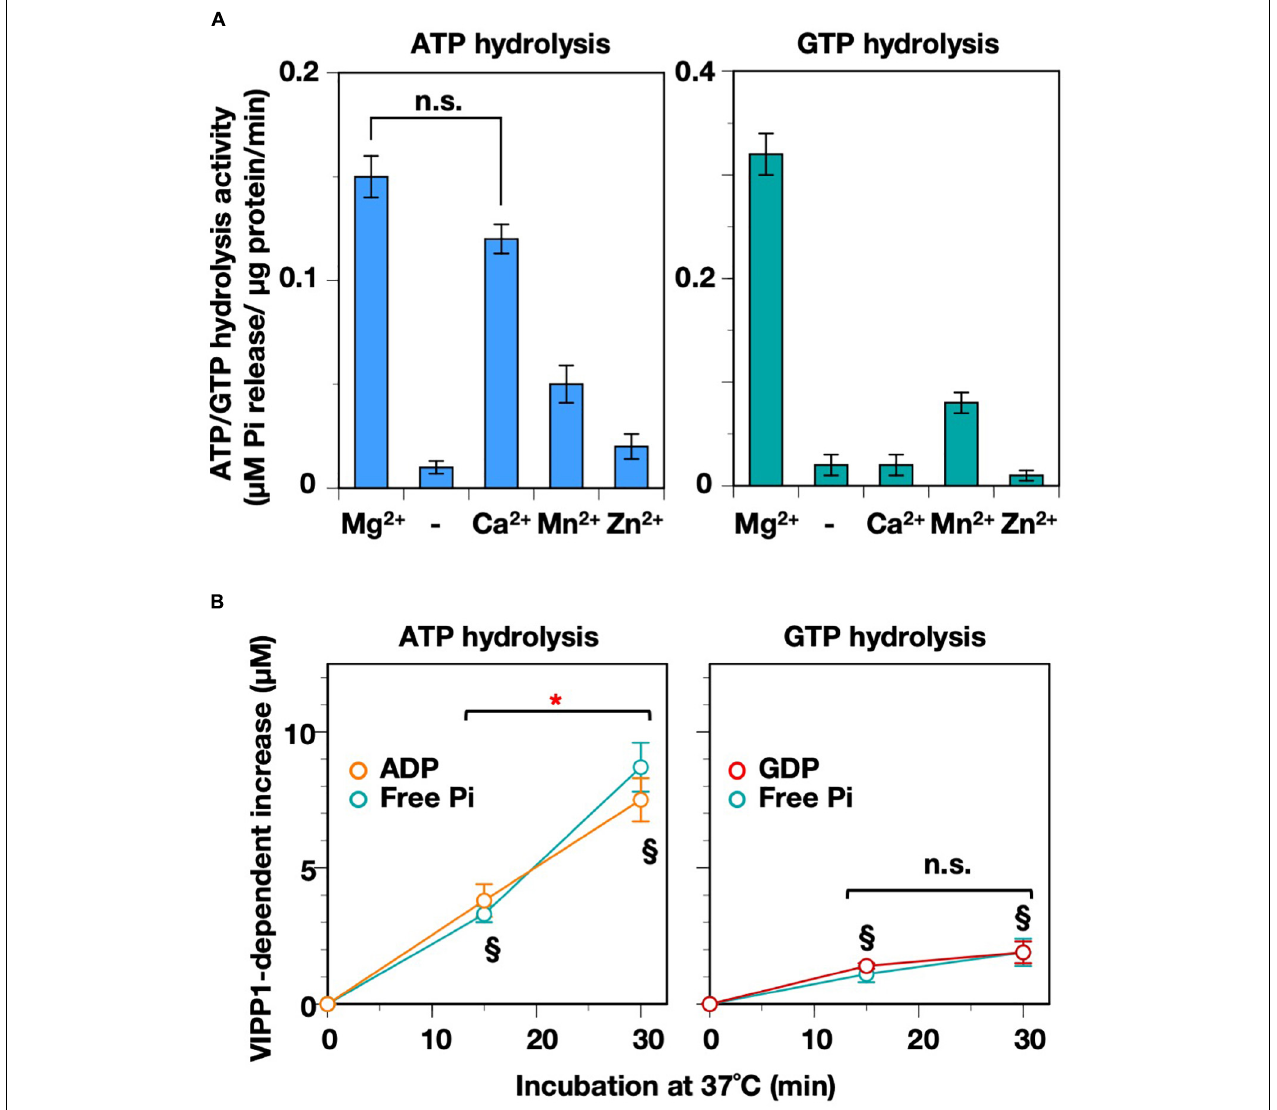
FIGURE 4 | Requirement for divalent cations. (A) Both ATP- and GTP-hydrolysis activities were measured in the absence (shown as “–”) or presence of four species of divalent cation (Mg 2 + , Ca 2 + , Mn 2 + , and Zn 2 + ). n.s.: No significant differences according to a statistical analysis (Welch’s t -test, p < 0.01). (B) Time course graphs indicating the increase in ADP and GDP in the presence of Ca 2 + , which were obtained from HPLC analyses on Supplementary Figure 4 . The level of Pi analyzed in the same conditions (with 2.5 µ g VIPP1-His protein) is also plotted on the graphs. An asterisk indicates a significant difference between the two time points, whereas there was no significant difference at the time points shown as “n.s.” according to a statistical analysis. § Denotes that there was no significant difference between the levels of ADP/GDP and that of free Pi at each time point (Welch’s t -test, p < 0.01, n = 4-6).